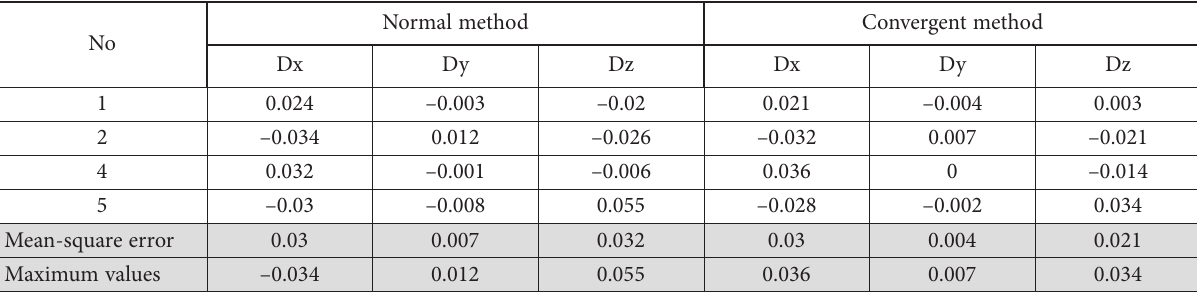
Table 5. Deviations at reference points